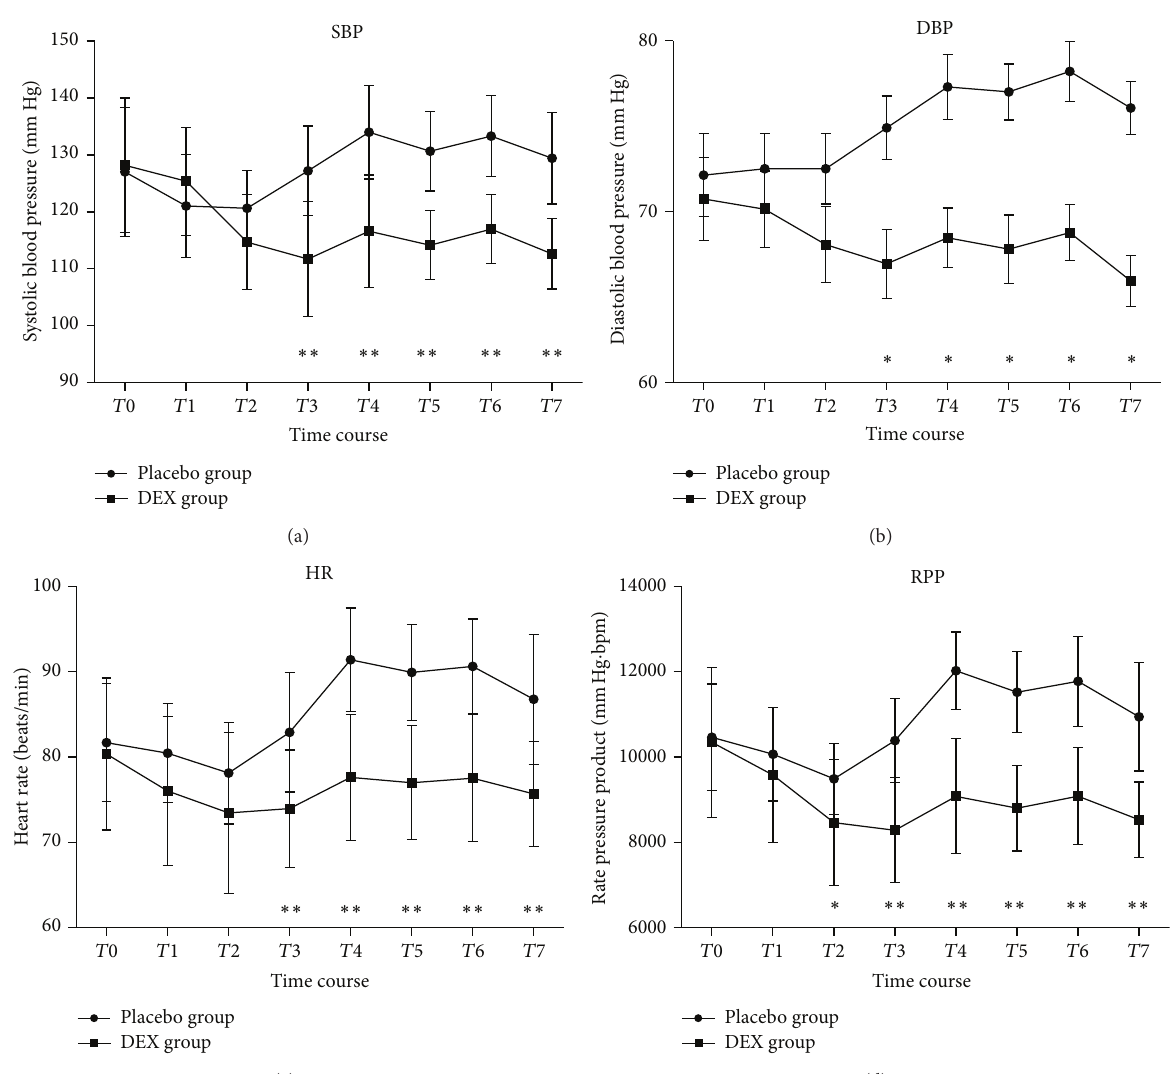
Figure 5: Hemodynamic variables of patients receiving intranasal DEX and placebo at each recording time point. Values are given as Mean ± SD. ∗ 𝑃 < 0.05 ; ∗∗ 𝑃 < 0.0001 . Baseline (T0), 5, 30 min after intranasal instillation (T1, 2), before local anesthesia (T3), the beginning of the operation (T4), 30 min after operation (T5), the end of operation (T6), and out of PACU (T7). Between-group comparison of hemodynamic variables at the same time period after intranasal drugs (from T3 to T7); DEX group was lower compared to Placebo group ( 𝑃 < 0.05 , 𝑃 < 0.0001 ,